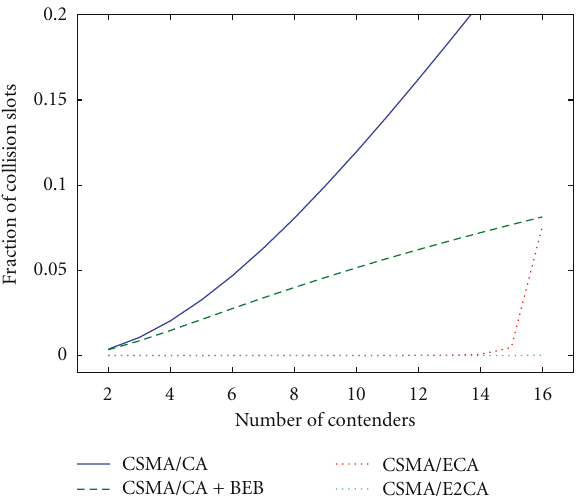
Figure 6: Fraction of collision slots for each of the three protocols under comparison for di ff erent number of contenders.